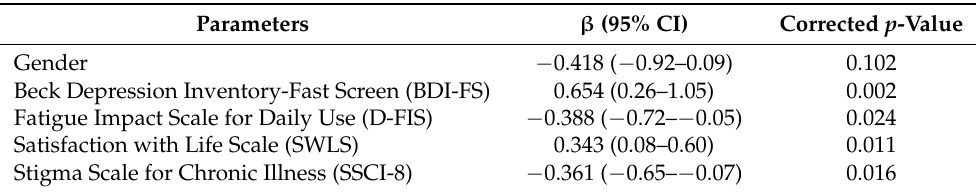
Table 3. Associations between the z-score of the global cognitive score (zBRB-N) and demographic, clinical and patient-centred measures. Parameters β (95% CI) Corrected p -Value Gender − 0.418 ( − 0.92–0.09) 0.102 Beck Depression Inventory-Fast Screen (BDI-FS) 0.654 (0.26–1.05) 0.002 Fatigue Impact Scale for Daily Use (D-FIS) − 0.388 ( − 0.72– − 0.05) 0.024 Satisfaction with Life Scale (SWLS) 0.343 (0.08–0.60) 0.011 Stigma Scale for Chronic Illness (SSCI-8) − 0.361 ( − 0.65– − 0.07)